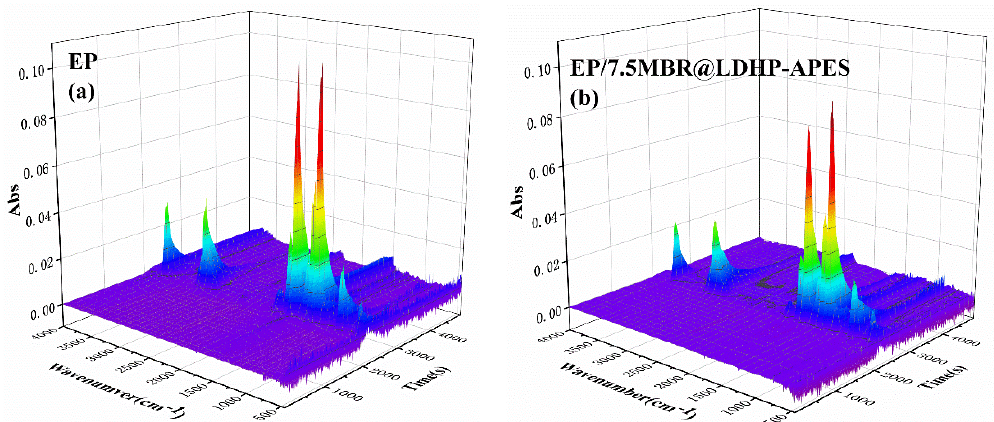
Figure 10. 3D TG-FTIR of samples ( a ) EP and ( b ) EP/7.5MBR@LDHP-APES.